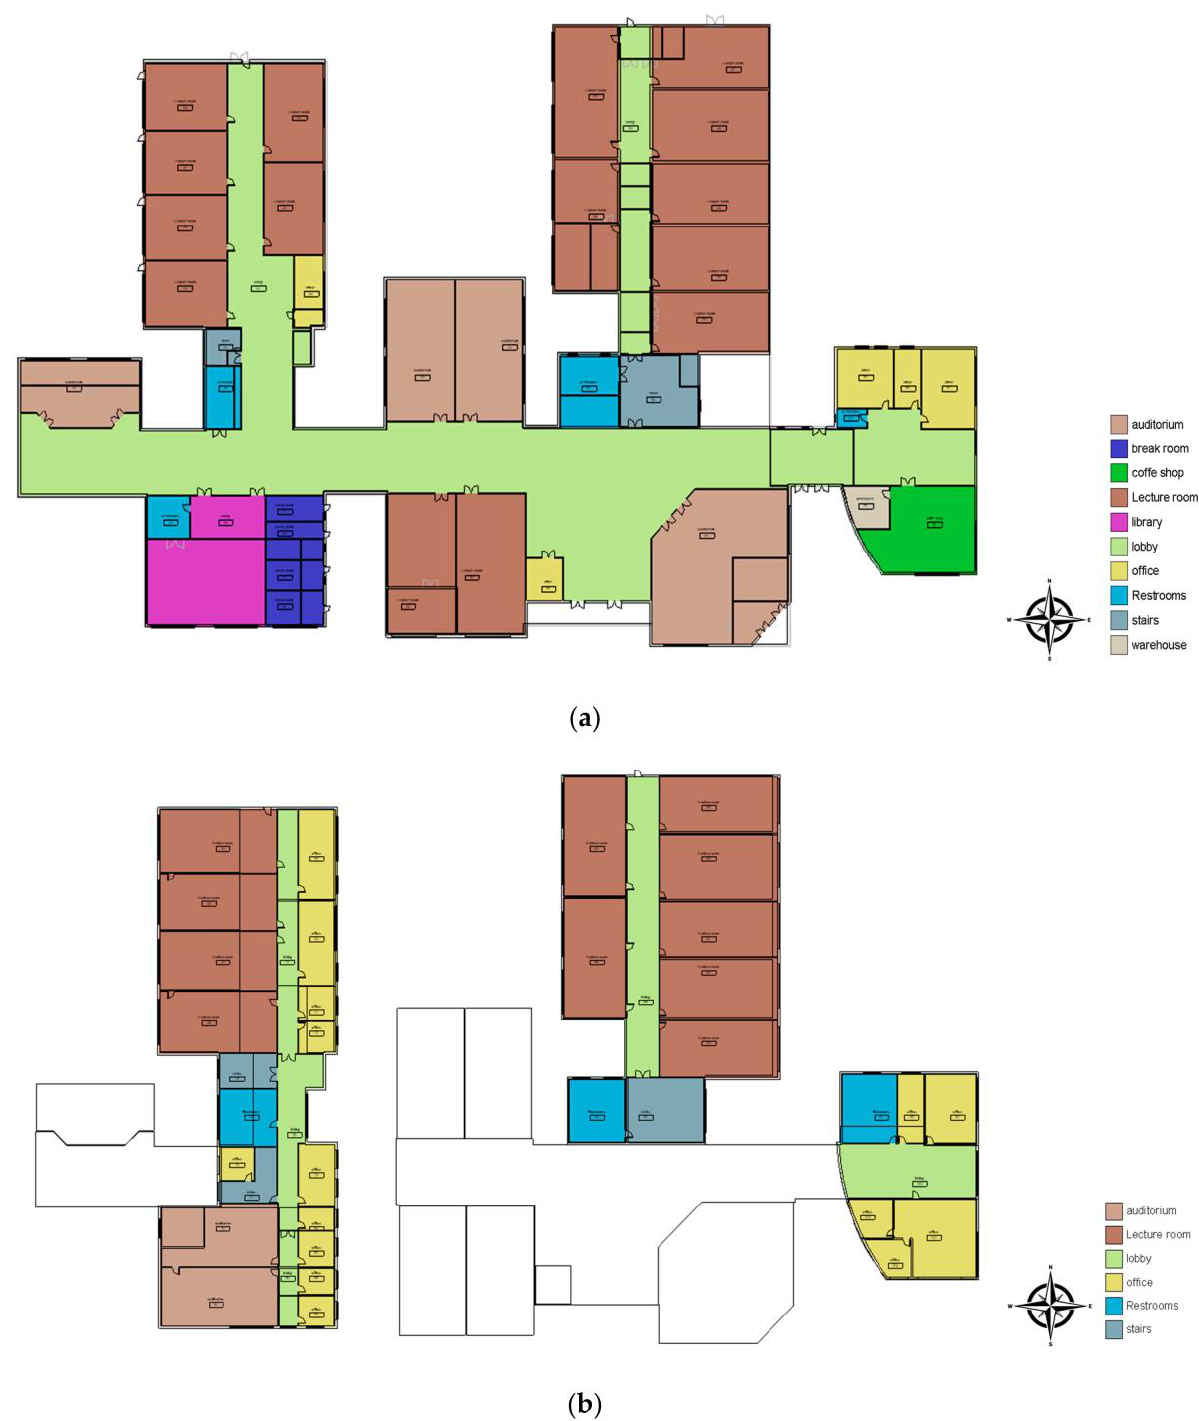
Table 1. Building Spaces and Areas ( m 2